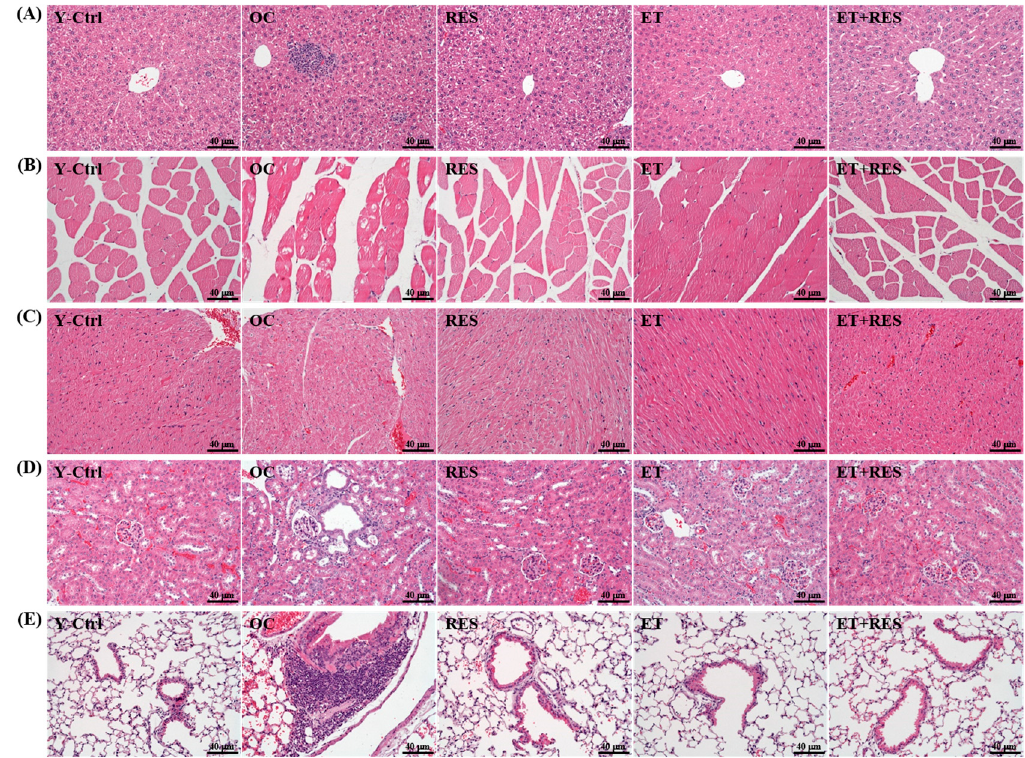
Figure 5. Effect of 4-week resveratrol (RES) supplementation and exercise training (ET) on histopathological evaluation of tissues, including ( A ) liver; ( B ) muscle; ( C ) heart; ( D ) kidney, and ( E ) lung. Mice were pretreated with the vehicle, RES, ET, and ET+RES for 28 days. Specimens were photographed with a light microscope (Olympus BX51). (Magnification: ×200, Scale bar, 40 μ m). Y-Ctrl, a young control group; OC, an older control; RES, a supplementation with RES group; ET, a ET group; ET+RES, a combination of ET and RES supplementation group.